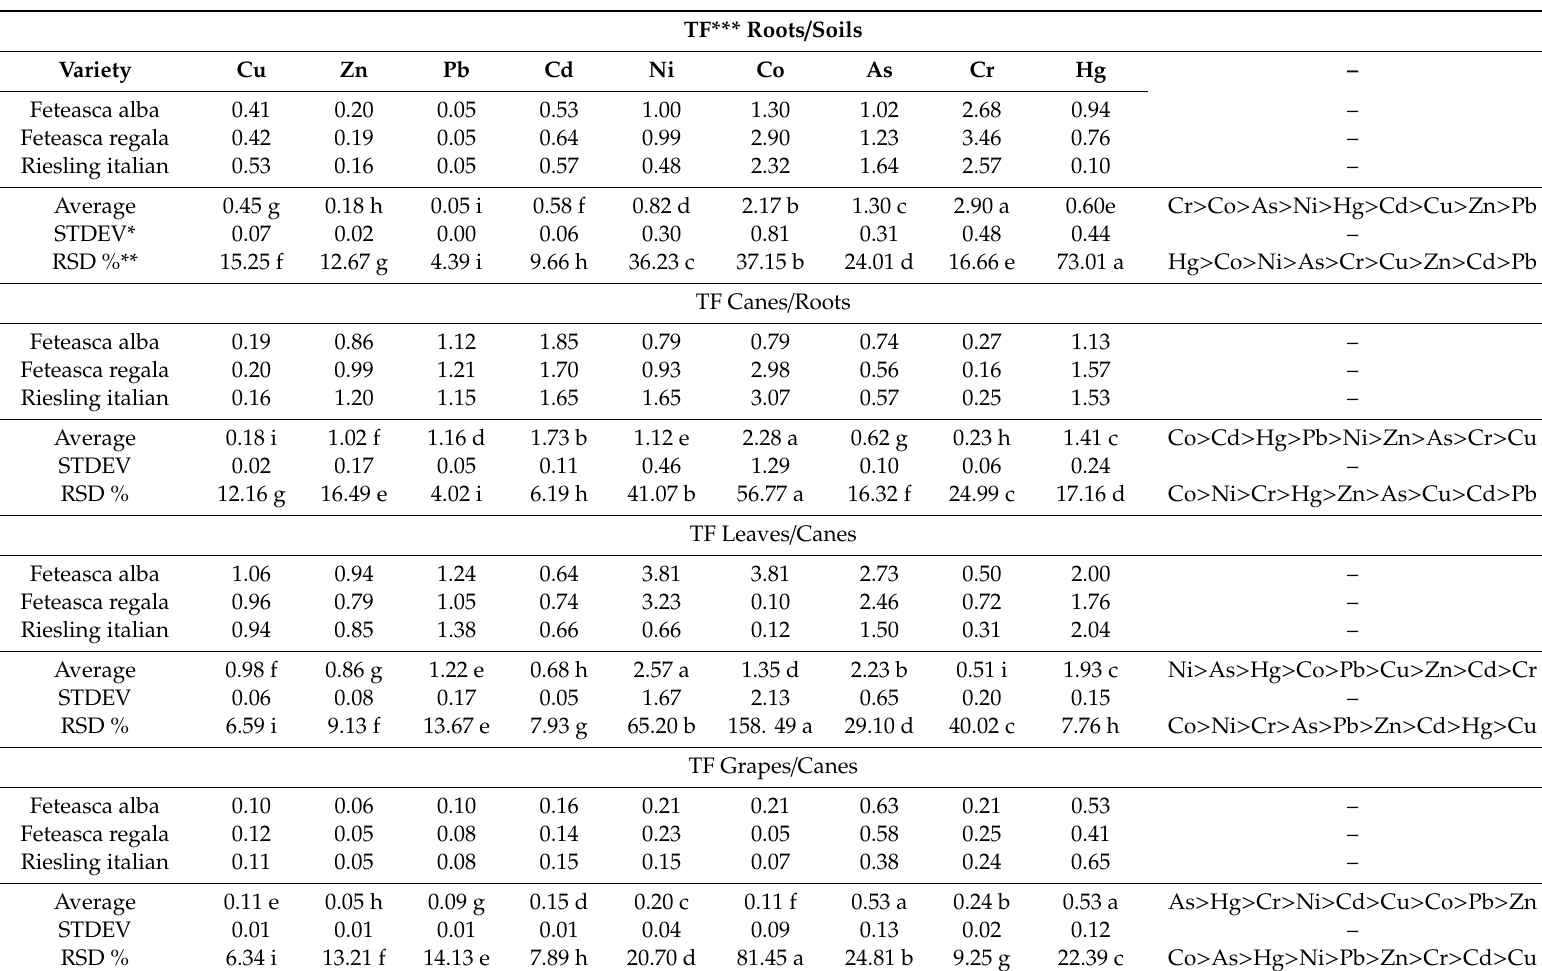
Table 5. The mean values of translocation factors in system soil-grape-wine. TF*** Roots /